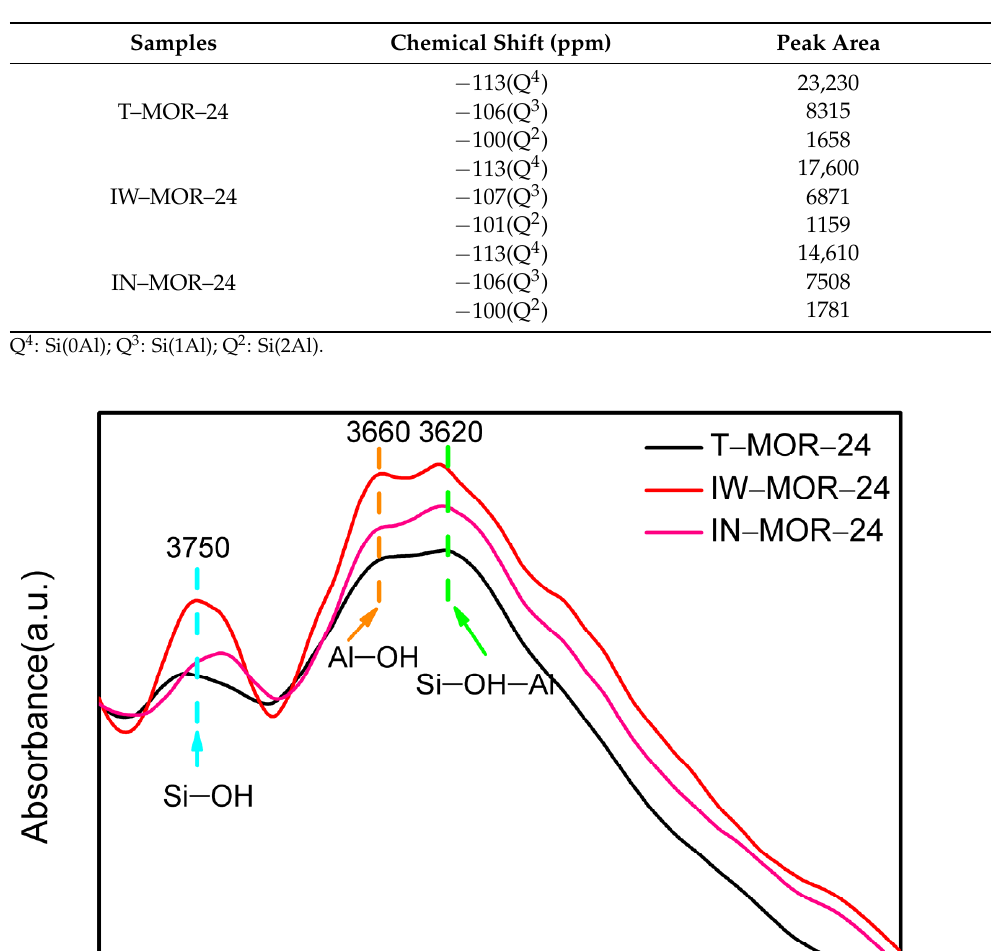
Table 3. 29 Si NMR result of MOR zeolites with hydrothermal synthesis method and ice–templating method.